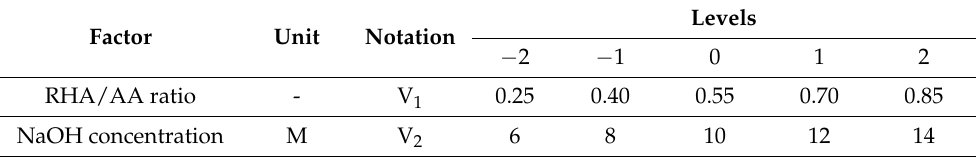
Table 2. Factors and